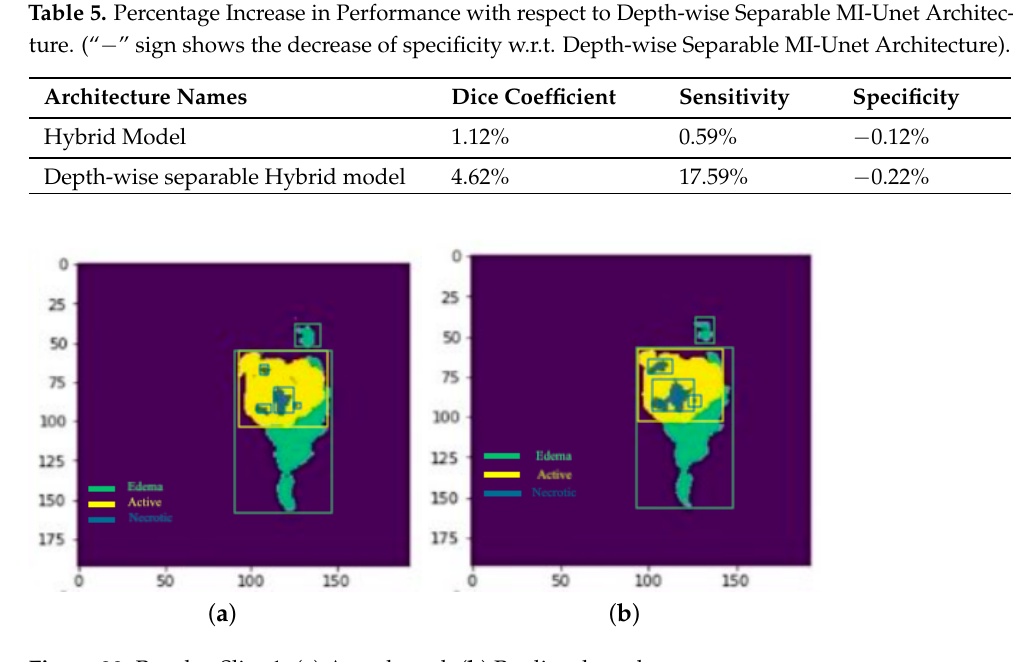
Table 5. Percentage Increase in Performance with respect to Depth-wise Separable MI-Unet Architec-